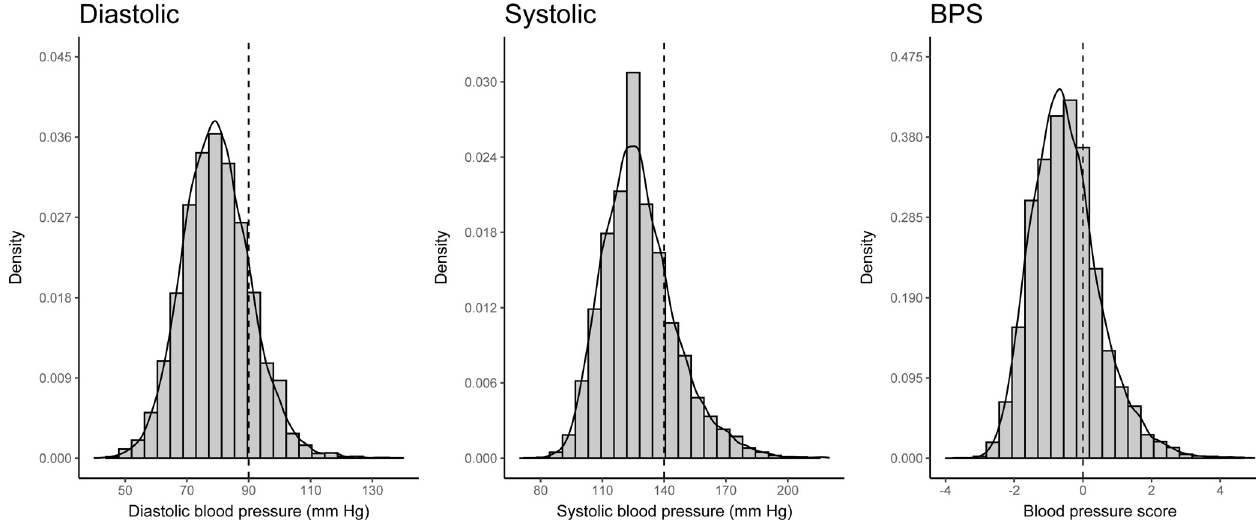
Fig 1. Density function of diastolic BP, systolic BP, and final BPS. BP, blood pressure; BPS, blood pressure score.